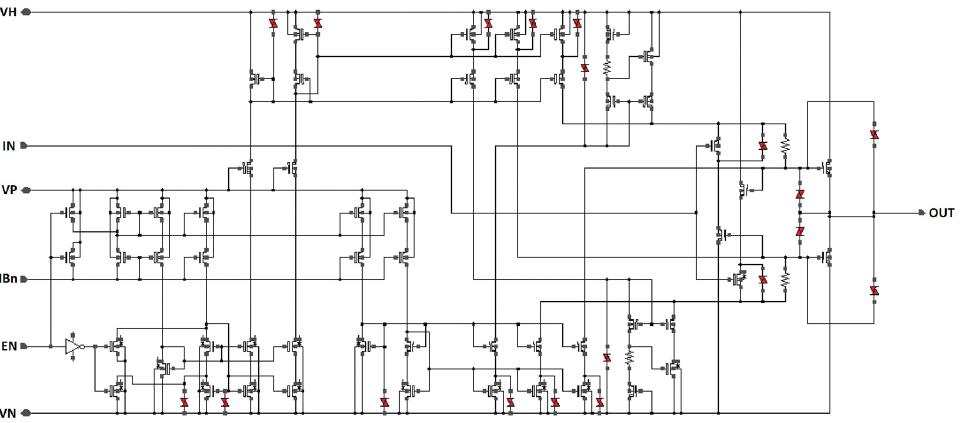
Figure 8. The buffer implemented with the AMS H35B4 0.35 μ m CMOS process.